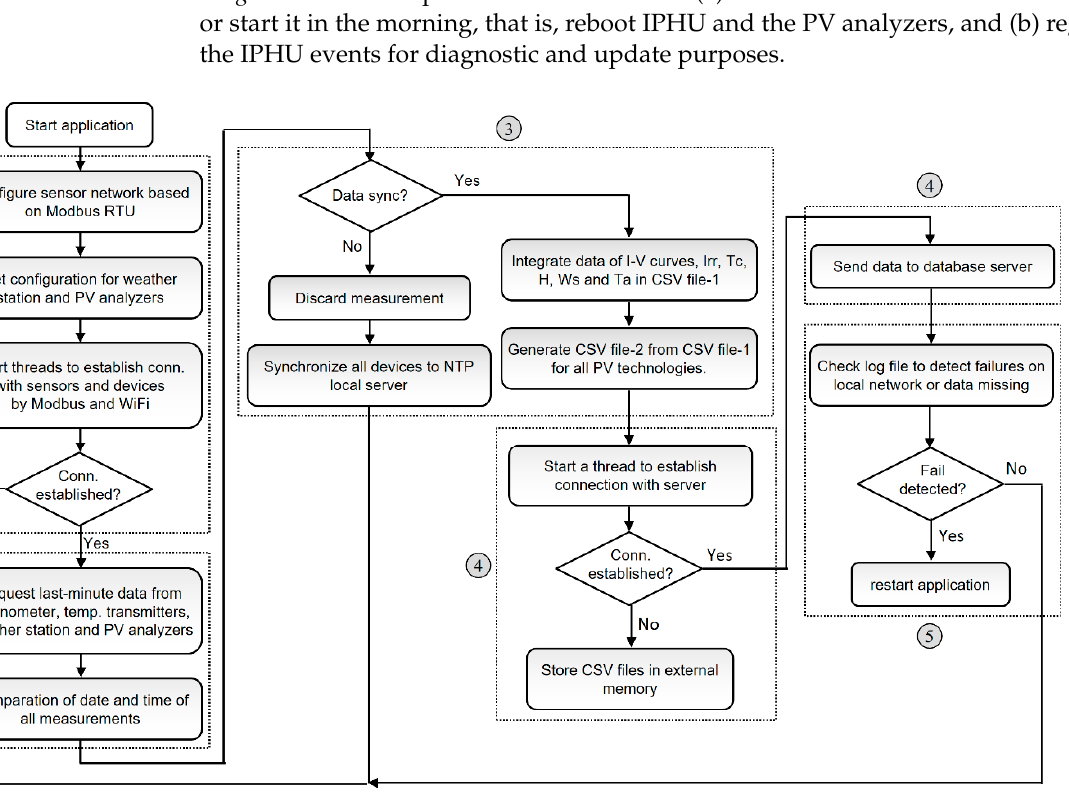
Figure 2. Procedures of IPHU software.